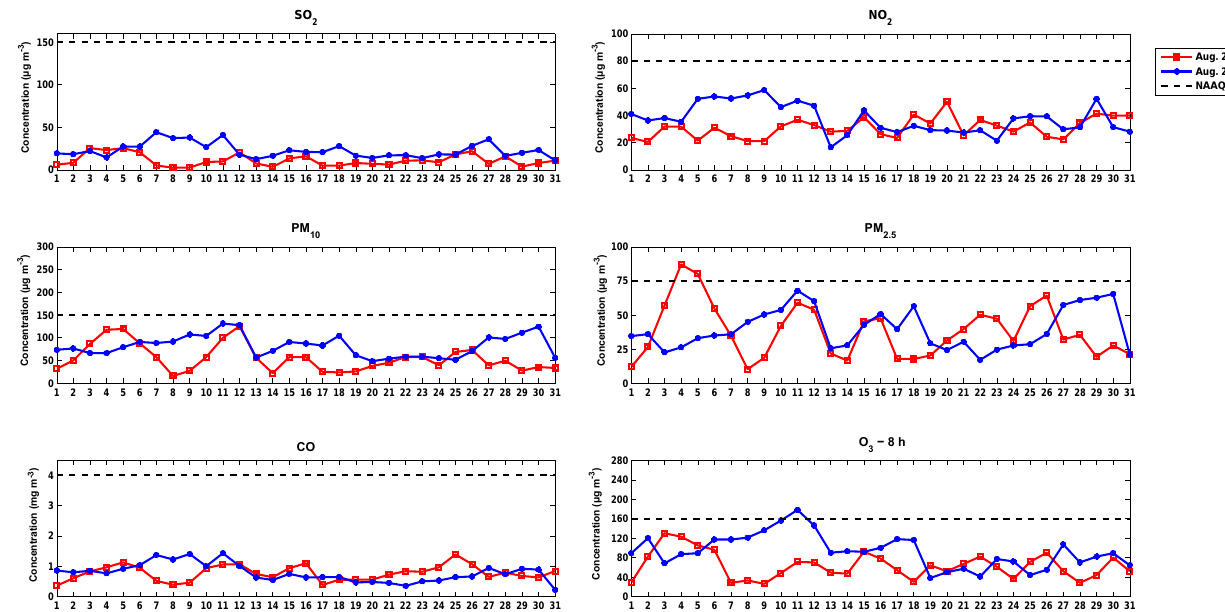
Figure 4. Day-to-day variations in SO 2 , NO 2 , PM 10 , PM 2 . 5 , CO and O 3 -8h at XL station in August 2013 and August 2014 (CST). Observed data for August 2013 and August 2014 are indicated in blue and red respectively. NAAQS are indicated with a black dotted line.